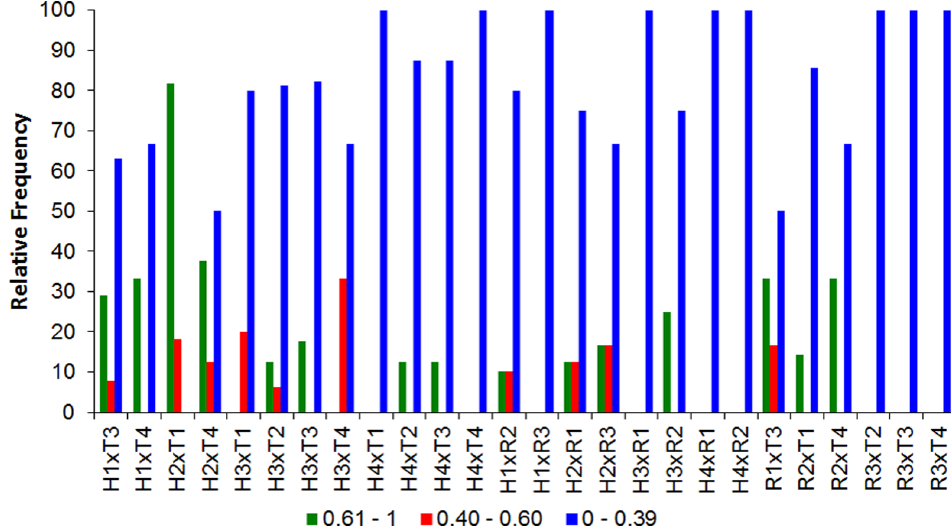
Figure 7. Pianka’s index results. Relative frequency of Pianka’s index of all pairwise interactions between the species with not compatible size classes per sampling unit. For specie/size class code see Table